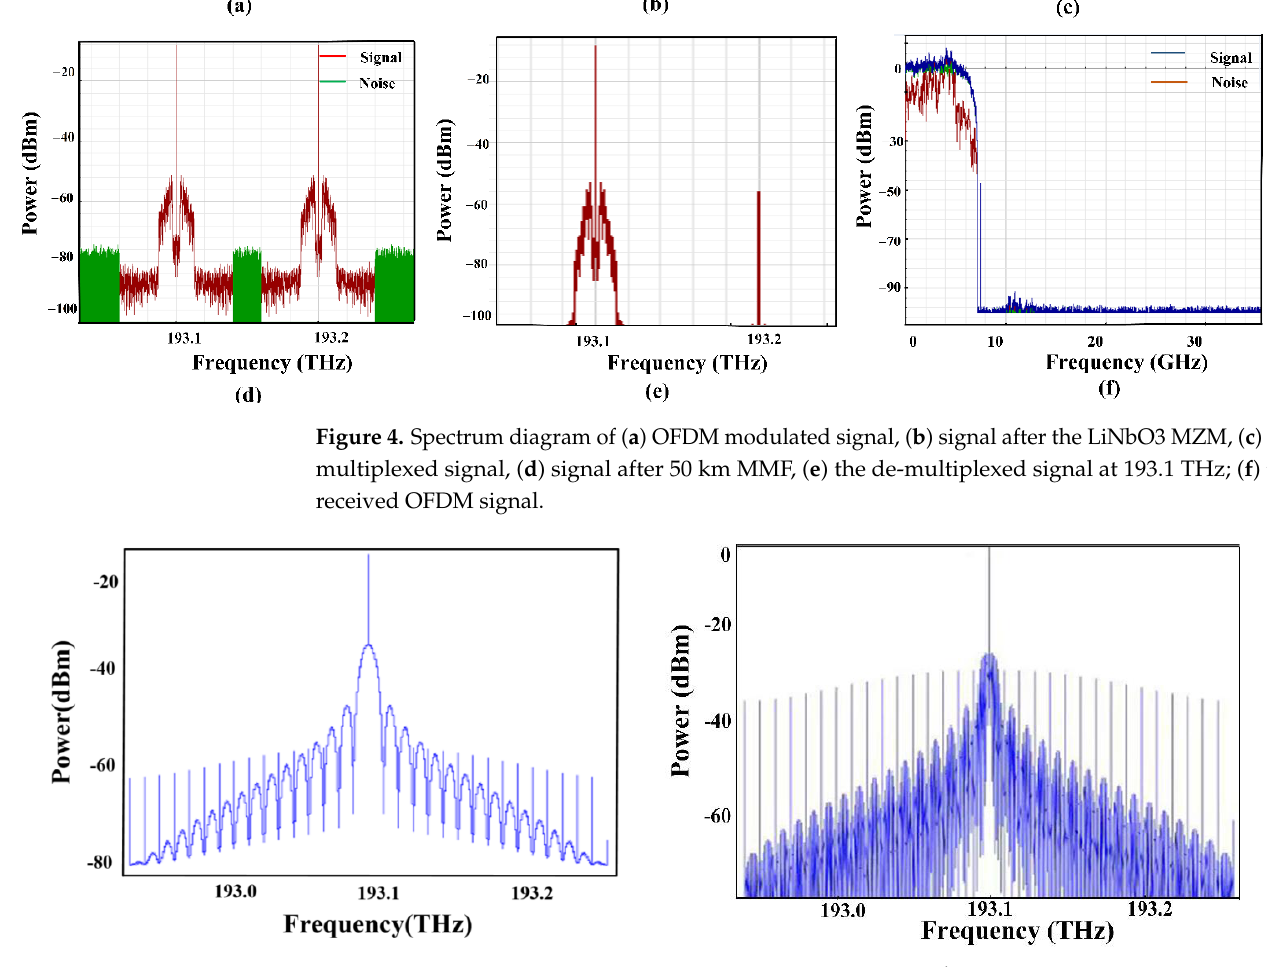
Table 1. The Main Parameters of the OAM-DM-WDM-OFDM-PON System. Component